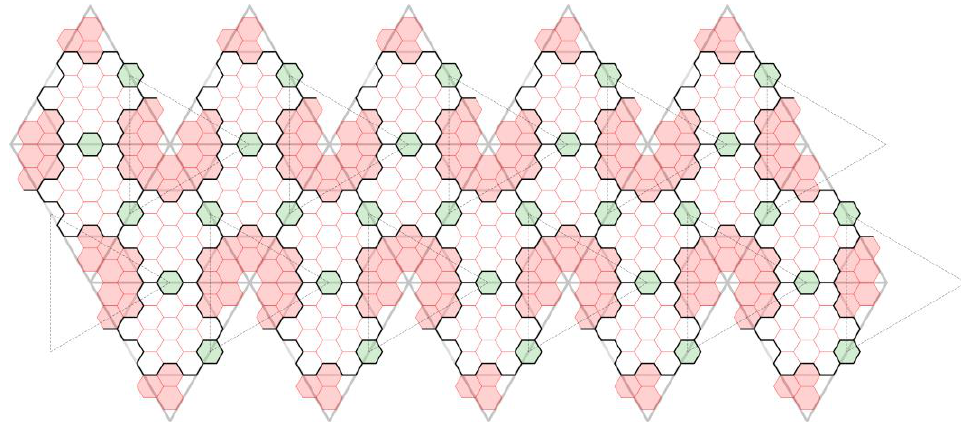
Figure 3. Vertex tiles and face tiles in the flattened